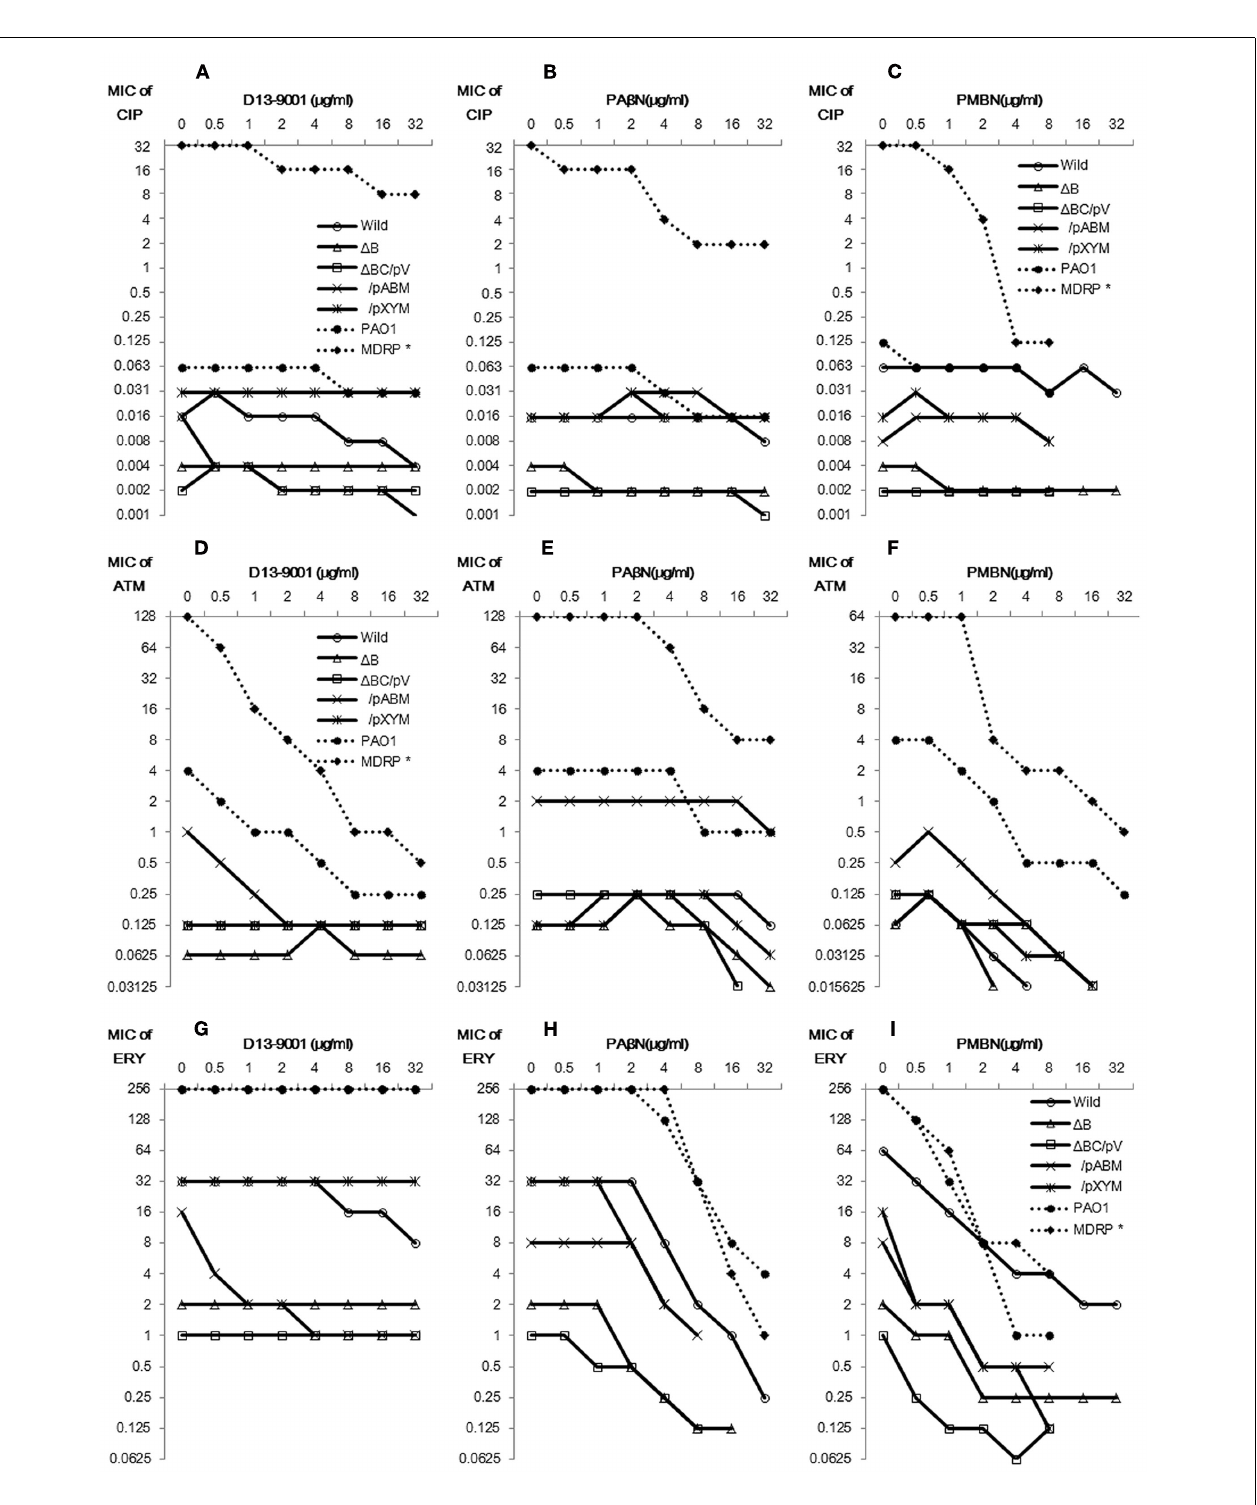
IMCJ2.S1 were used. Changes in the MICs of ciprofloxacin [CIP: (A-C) ], aztreonam [ATM: (D-F) ], and erythromycin [ERY: (G-I) ] induced by D13-9001 (A,D,G) , PA β N (B,E,H) , or PMBN (C,F,I) were determined by checkerboard method. Modified from Matsumoto et al.